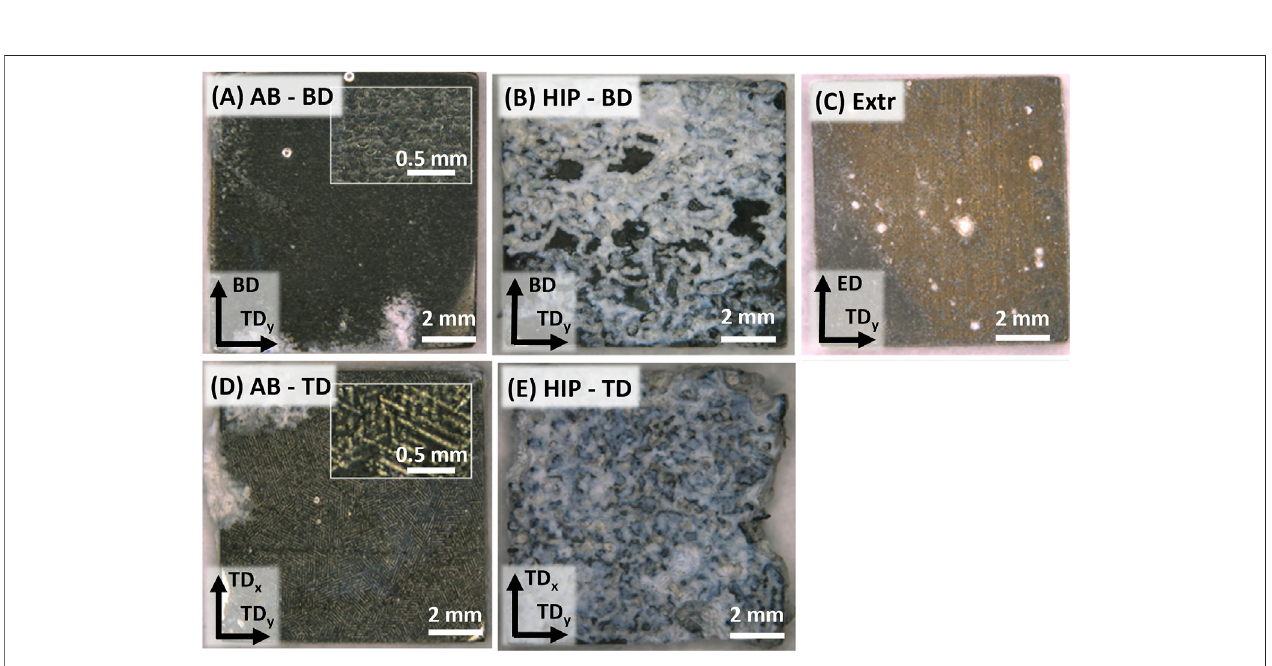
Frontiers in Bioengineering and Biotechnology |